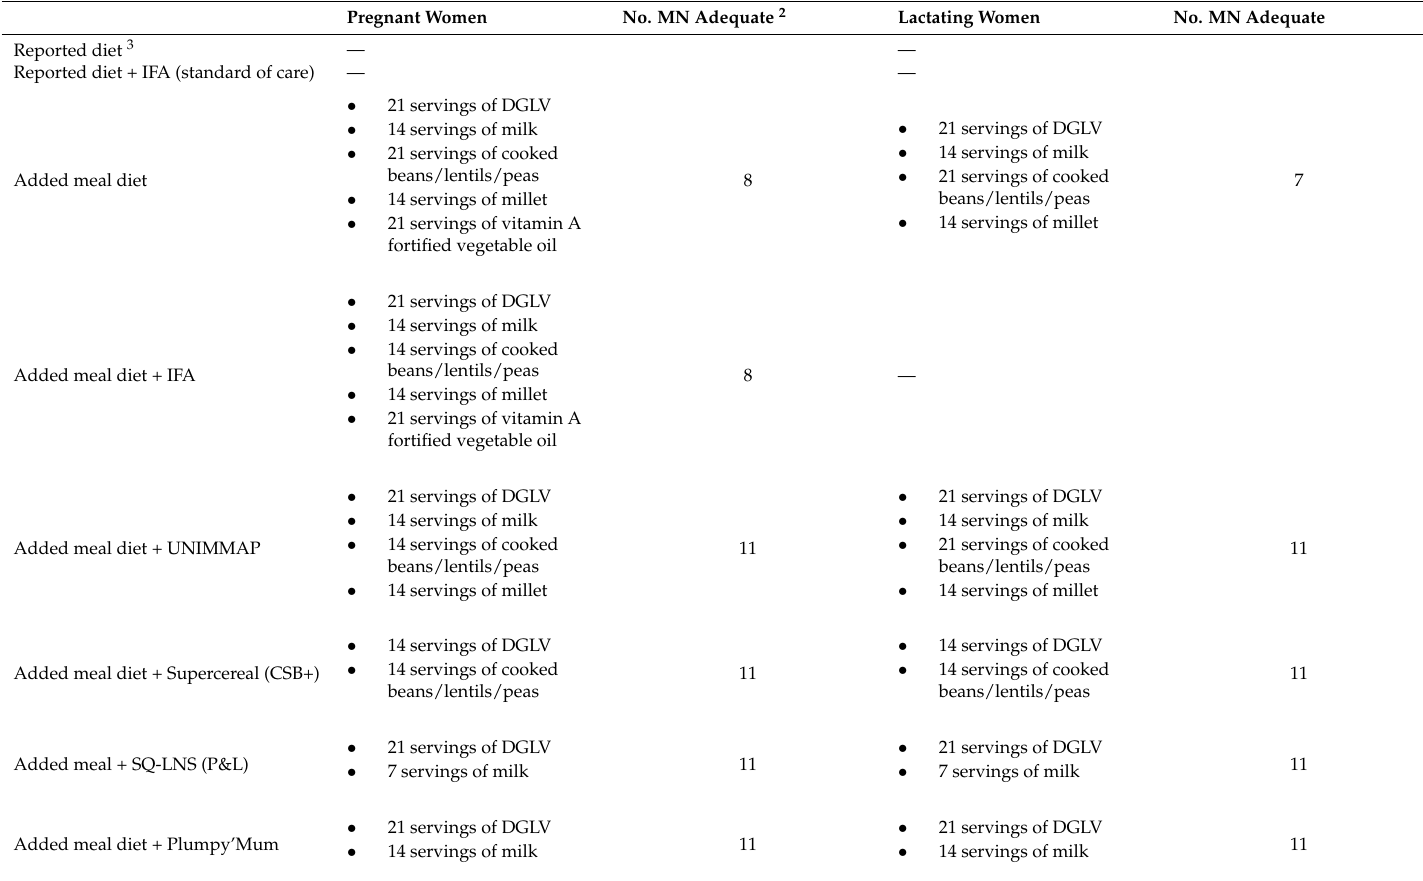
Table 6. Food-based recommendations for pregnant and lactating women, by model series and intervention product 1 . Pregnant